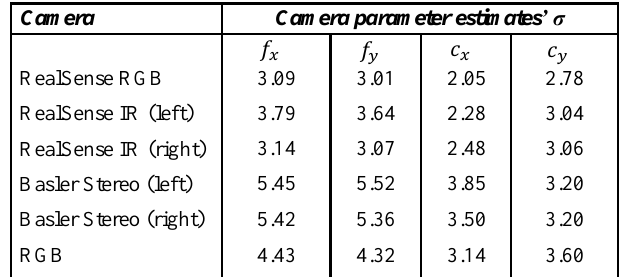
Table 2: Standard deviations of pinhole camera model parameters Camera